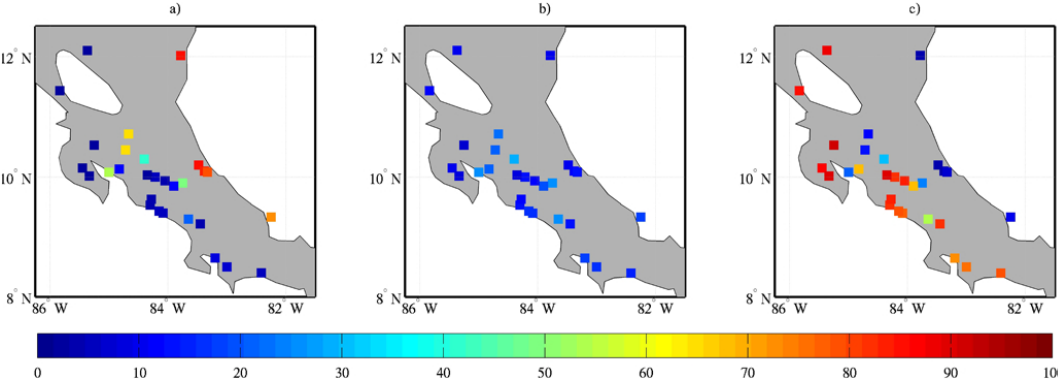
Fig. 12. CCA precipitation forecasts for ASO 2010 percentage of values below the 10th percentile (p10) using July SST as predictor. Forecast probability maps are for categories (a) Above, (b) Normal, (c) Below. Table 4. Validation of the precipitation accumulates (ACM) forecast for ASO 2010. The observed values were reported by 24 gauge stations from Costa Rican Meteorological and Hydrological Services (Fig. 1). Categories are: Below (B), Normal (N) and Above (A). Station Longitude Latitude Observed Observed Forecasted ACM